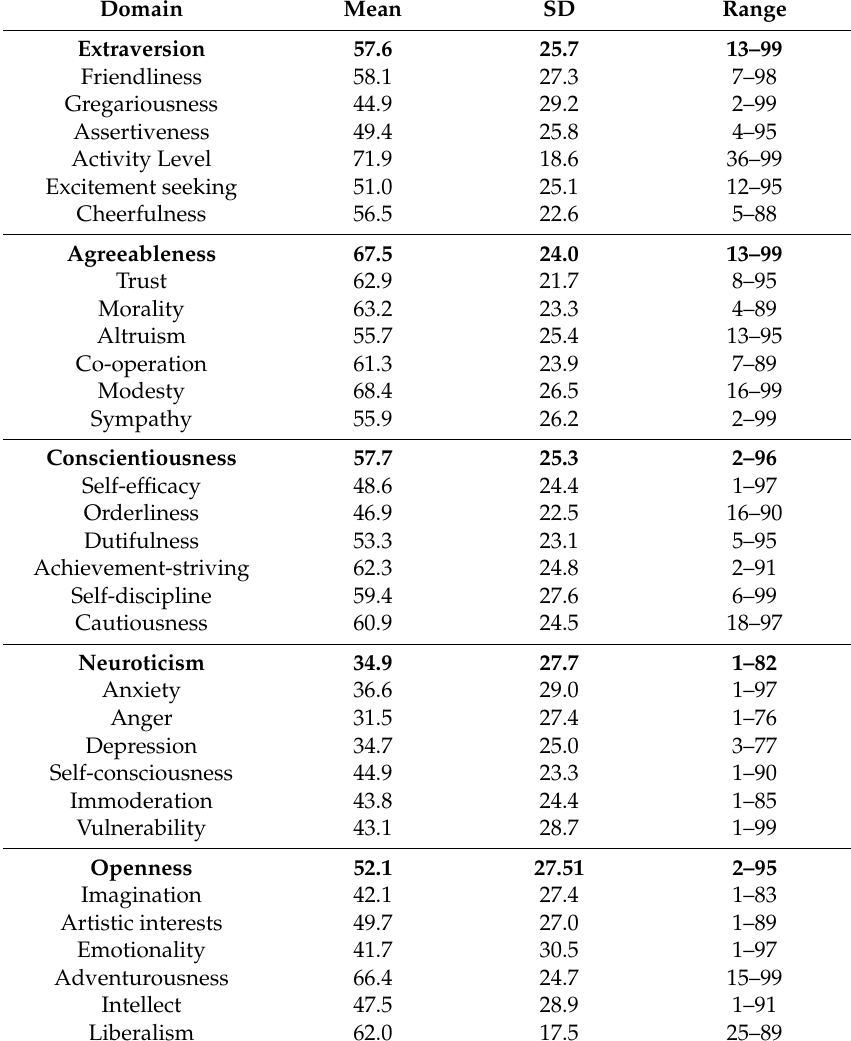
Table 3. The dog handlers’ personality scores in the five main personality domains (in bold), and the traits (shown below each domain) within these domains. The standard deviation and range is also